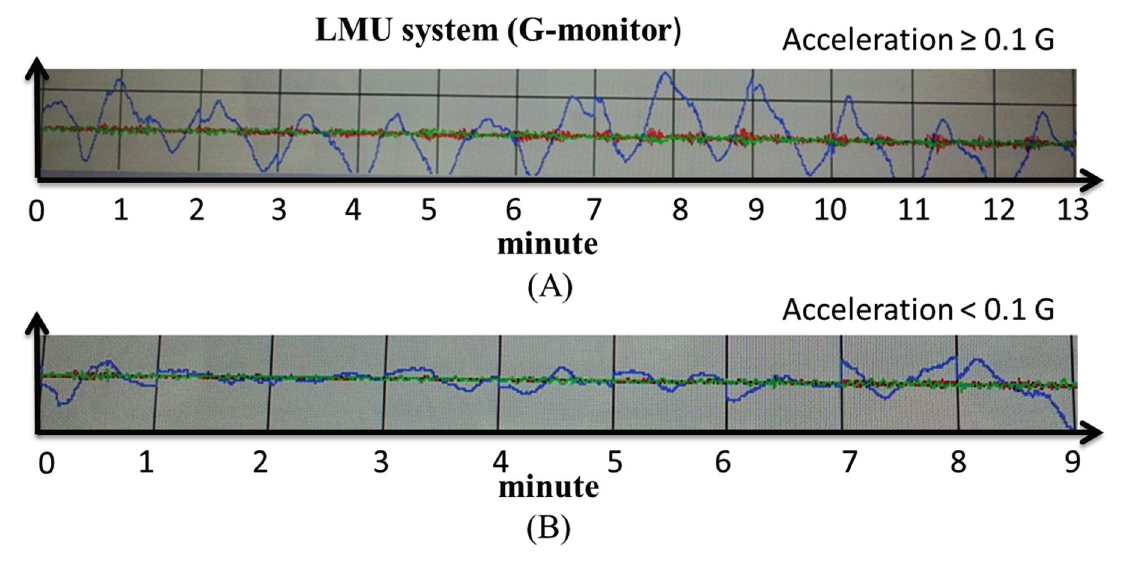
Figure 2. The accelerating speed of the platform was created using a machine, and the acceleration were monitored with an LMU system (G-monitor). Acceleration was